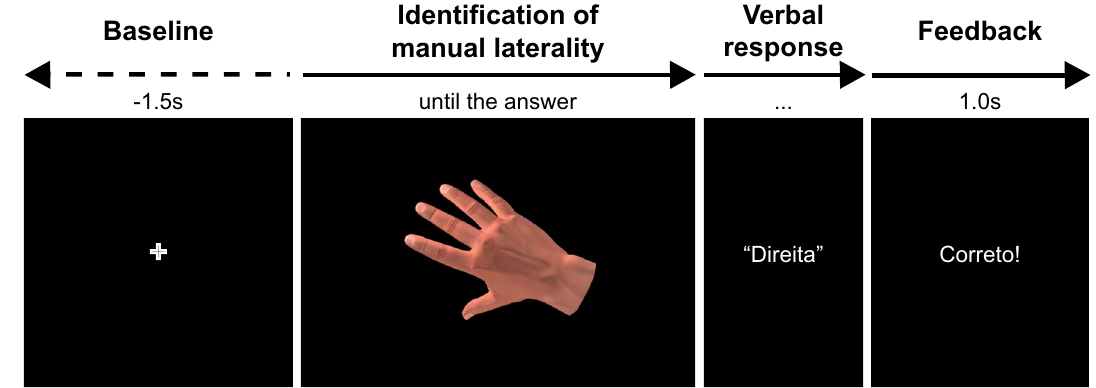
Figure 3. Sequence of events for the HLJT experimental protocol. First, a cross appeared on the screen. It was replaced by a hand stimulus. The hand remained on the screen until the verbal response of the participant. After the answer, feedback appeared on the screen indicating success or